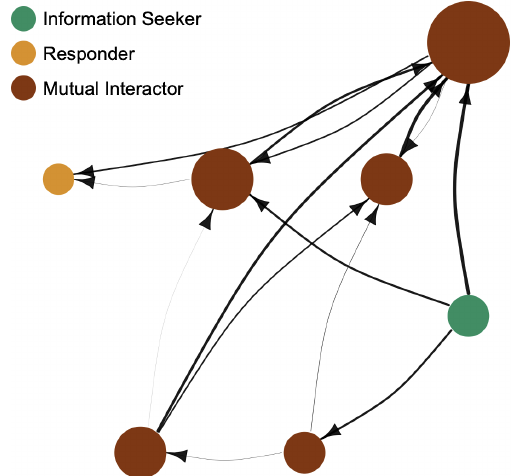
FIG. 5. Network diagram of session 2 of section 4. Each node represents a lab group and is positioned according to the actual table layout of the classroom (Fig. 1). Node size is proportional to degree. Edge thickness is proportional to strength. Edge arrows point from the group that initiated the interaction to the responding group. Nodes are colored by the social role assigned to them by our